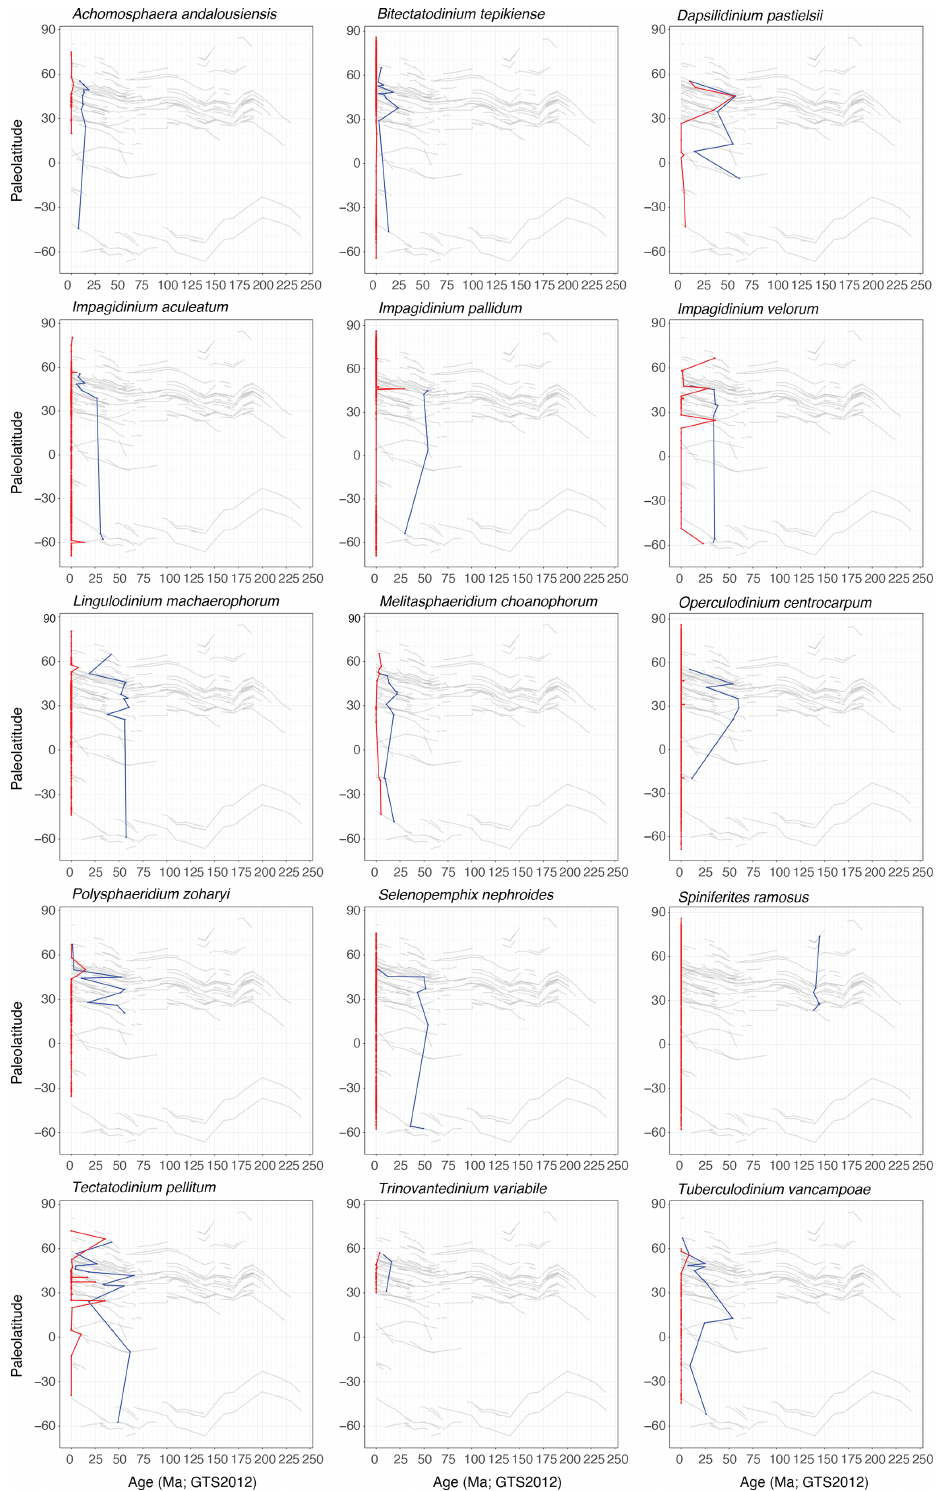
Figure 4. Age and paleolatitude of first (in blue) and last (in red) occurrences of selected modern dinocyst species. Last occurrences come from both the surface sediment database (Marret et al., 2020, with Mertens et al., 2014) and entries in DINOSTRAT.